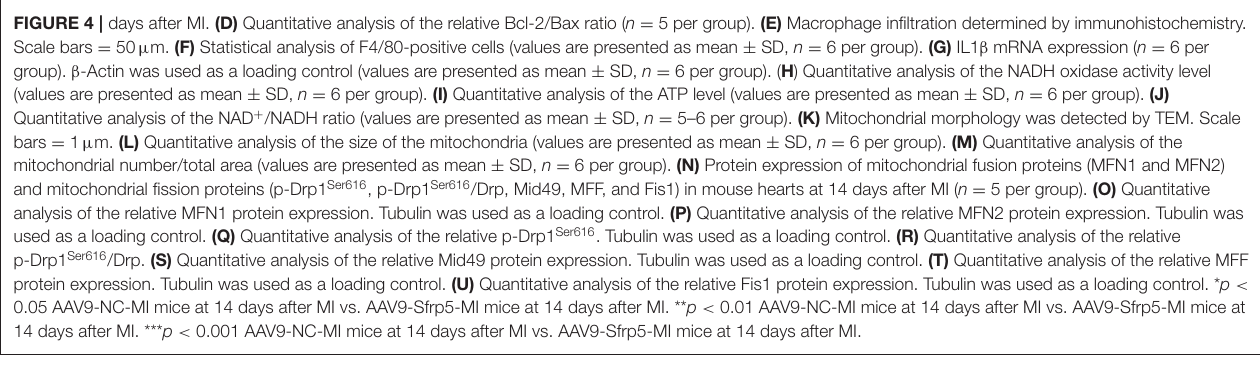
FIGURE 4 | days after MI. (D) Quantitative analysis of the relative Bcl-2/Bax ratio ( n = 5 per group). (E) Macrophage infiltration determined by immunohistochemistry. Scale bars = 50 µ m. (F) Statistical analysis of F4/80-positive cells (values are presented as mean ± SD, n = 6 per group). (G) IL1 β mRNA expression ( n = 6 per group). β -Actin was used as a loading control (values are presented as mean ± SD, n = 6 per group). ( H ) Quantitative analysis of the NADH oxidase activity level (values are presented as mean ± SD, n = 6 per group). (I) Quantitative analysis of the ATP level (values are presented as mean ± SD, n = 6 per group). (J) Quantitative analysis of the NAD + /NADH ratio (values are presented as mean ± SD, n = 5–6 per group). (K) Mitochondrial morphology was detected by TEM. Scale bars = 1 µ m. (L) Quantitative analysis of the size of the mitochondria (values are presented as mean ± SD, n = 6 per group). (M) Quantitative analysis of the mitochondrial number/total area (values are presented as mean ± SD, n = 6 per group). (N) Protein expression of mitochondrial fusion proteins (MFN1 and MFN2) and mitochondrial fission proteins (p-Drp1 Ser616 , p-Drp1 Ser616 /Drp, Mid49, MFF, and Fis1) in mouse hearts at 14 days after MI ( n = 5 per group). (O) Quantitative analysis of the relative MFN1 protein expression. Tubulin was used as a loading control. (P) Quantitative analysis of the relative MFN2 protein expression. Tubulin was used as a loading control. (Q) Quantitative analysis of the relative p-Drp1 Ser616 . Tubulin was used as a loading control. (R) Quantitative analysis of the relative p-Drp1 Ser616 /Drp. (S) Quantitative analysis of the relative Mid49 protein expression. Tubulin was used as a loading control. (T) Quantitative analysis of the relative MFF protein expression. Tubulin was used as a loading control. (U) Quantitative analysis of the relative Fis1 protein expression. Tubulin was used as a loading control. * p < 0.05 AAV9-NC-MI mice at 14 days after MI vs. AAV9-Sfrp5-MI mice at 14 days after MI. ** p < 0.01 AAV9-NC-MI mice at 14 days after MI vs. AAV9-Sfrp5-MI mice at 14 days after MI. *** p < 0.001 AAV9-NC-MI mice at 14 days after MI vs. AAV9-Sfrp5-MI mice at 14 days after